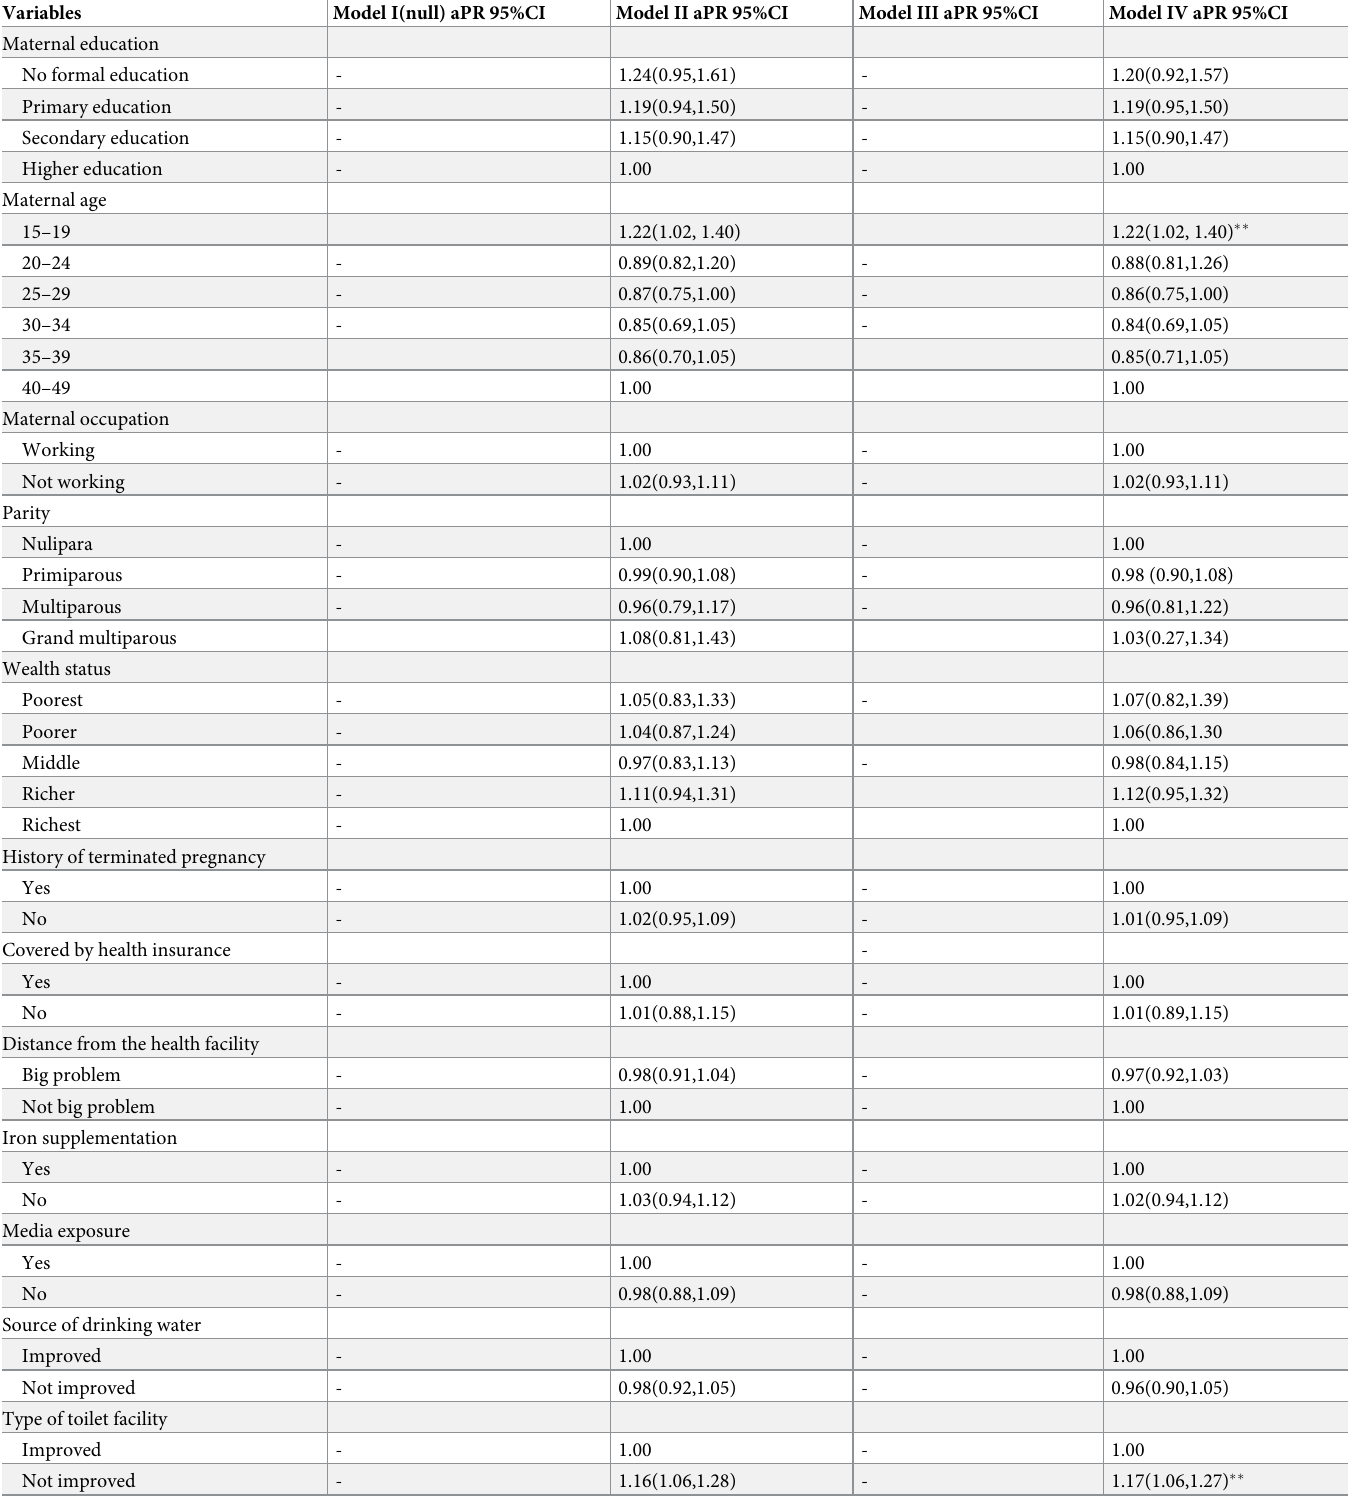
Table 4. Determinants of anemia among pregnant women in East